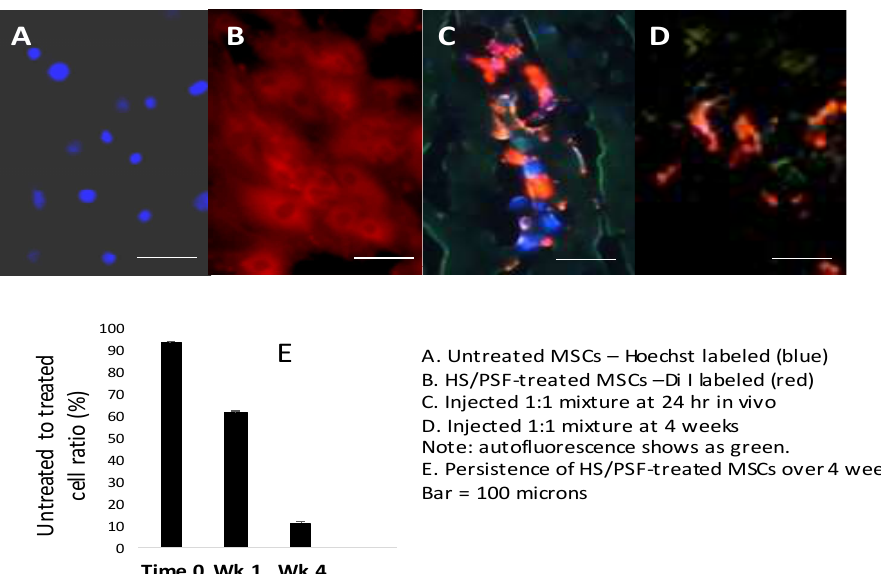
Figure 4. In vivo analysis of cell survival following HS/PSF treatments. ( A ) Hoechst 33,342 labeled untreated GFP-rMSCs and HS/PSF-treated, and Di I labeled GFP-rMSCs in the cell cultures prior to injections into rat hearts. ( B ) Mixed untreated (Hoechst) and HS/PSF-treated (Di I) cells injected into infarcted rat heart and sectioned at 24 h. At this time, equal numbers of untreated and HS/PSF- treated cells could be found. ( C ) However, at 1 week, there were 0.6 Hoechst untreated cells for every HS/PSF-treated cells, and untreated rMSCs declined thereafter. ( D ) At 4 weeks, both groups declined but many more HS/PSF-treated MSCs were present, but very few untreated MSCs were found. At 8 weeks, it was difficult to find any DAPI labeled untreated MSCs, while the HS/PSF-treated MSCs could be found but in reduced numbers compared with the 4-week time point. ( E ) Ratio of HS/PSF-treated GFP-rMSC over untreated GFP-rMSC in rat infarcted heart tissue at 1 and 4 weeks post injections. Bar = 100 µm.